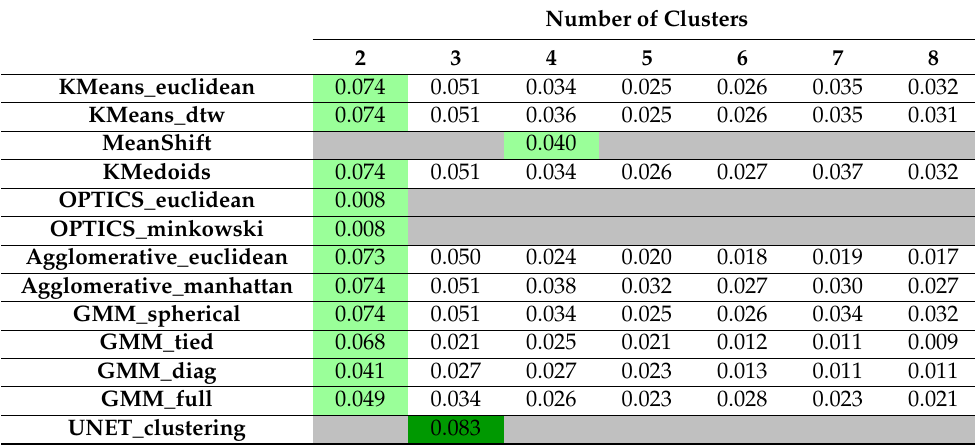
Table 2. Global indicator χ value depending on the clustering method and the number of